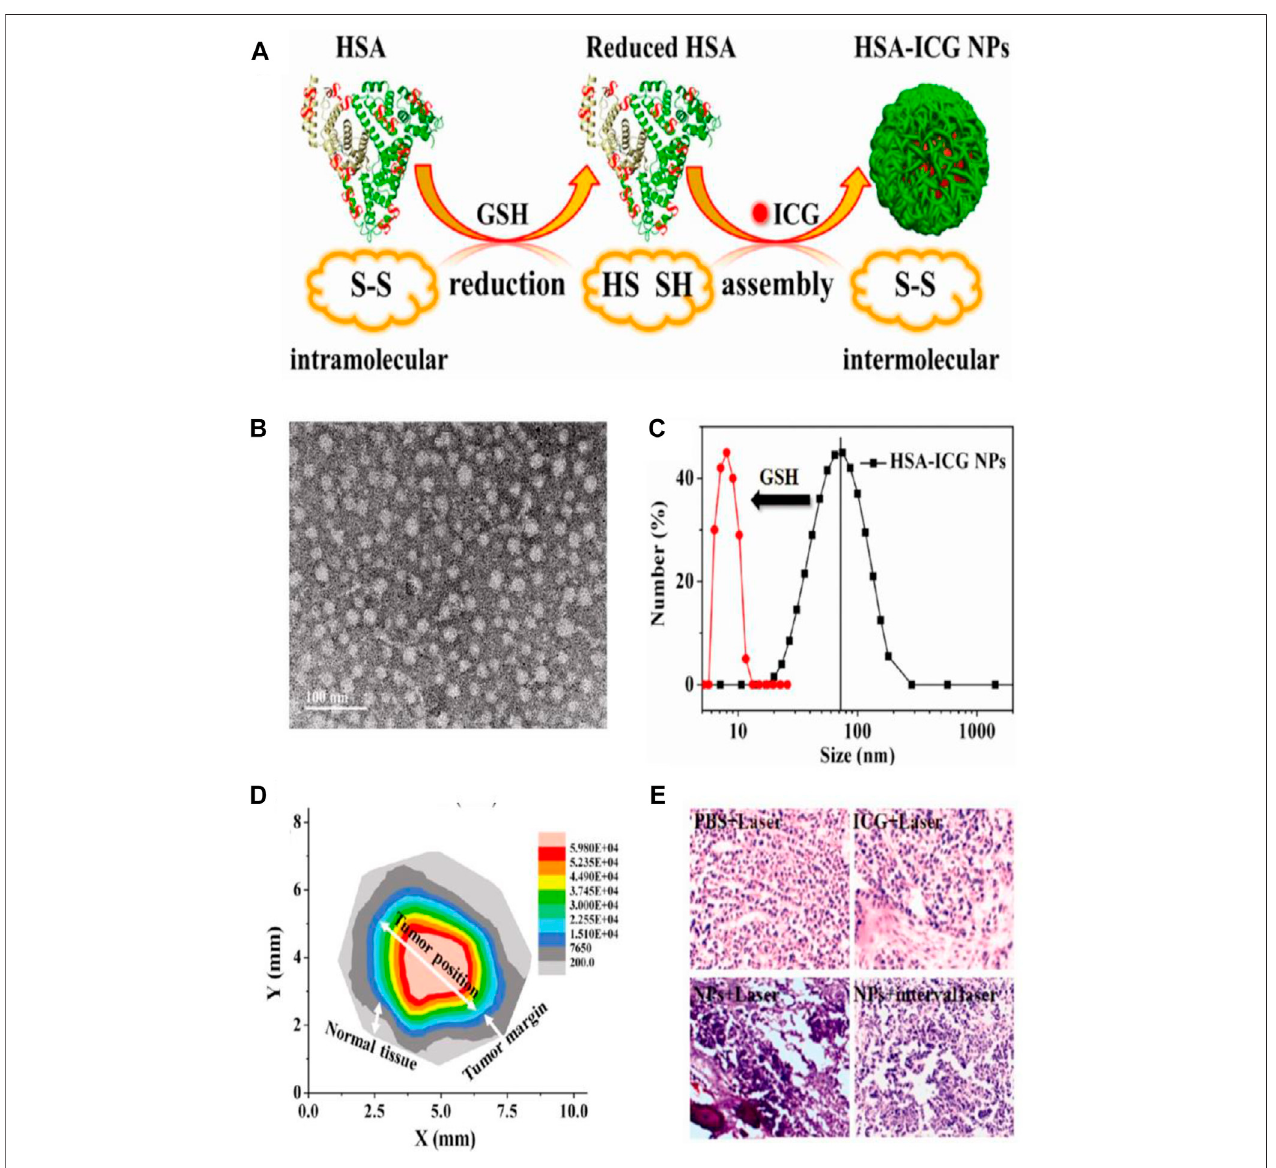
FIGURE 6 | Phototherapy-based cancer theranostics. (A) Schematic illustration of the synthesis procedure of human serum albumin (HSA) – indocyanine green (ICG) NPs. (B) TEM image of HSA – ICG NPs. (C) Size distribution of HSA-ICG NPs measured by DLS. (D) Tumor mapping imaging with integrated FL intensity of HSA – ICGNPsatdifferentlocations. (E) Thehematoxylinandeosin(HandE)-stainedimagesoftumorsectionscollectedfromdifferenttreatedgroups(PBS+Laser;ICG + Laser; NPs + Laser; NPs + interval Laser) of mice at 4 h post-injection via tail vein. Reproduced with permission from Sheng et al. (2014). Copyright 2014, American Chemical